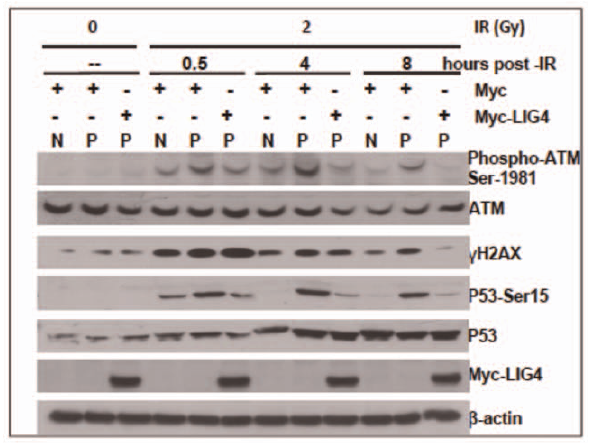
Figure 10. expression of LIG4 in CoDa cells does not affect the initial activation of ATM, p53, and H2AX, but eliminates the excessive residual level of phosphorylated ATM, p53, and H2AX after irradiation. After irradiation with 2 Gy of c -rays, whole cell extracts were collected at various time points and subjected to western-blot analyses to measure the phosphorylations of ATM (Ser1981), p53 (Ser15), and H2AX (Ser139), and b -actin was used as loading control. Myc or Myc-LIG4 represents the cells were infected with retrovirus expressing Myc or My-LIG4, respectively. Protein samples from FBCL cells are labeled as ‘‘N’’, from CoDa cells are labeled as Figure S1 CoDa cells have normal RAD51and phos- phorylated DNA-PKcs focus formation. RAD51 focus formation in response to DNA damage is a hallmark of active HR machinery. Failure or delay in forming RAD51 foci would signal an impaired HR process. To integrate whether the homologous recombinational repair pathway is affected in CoDa